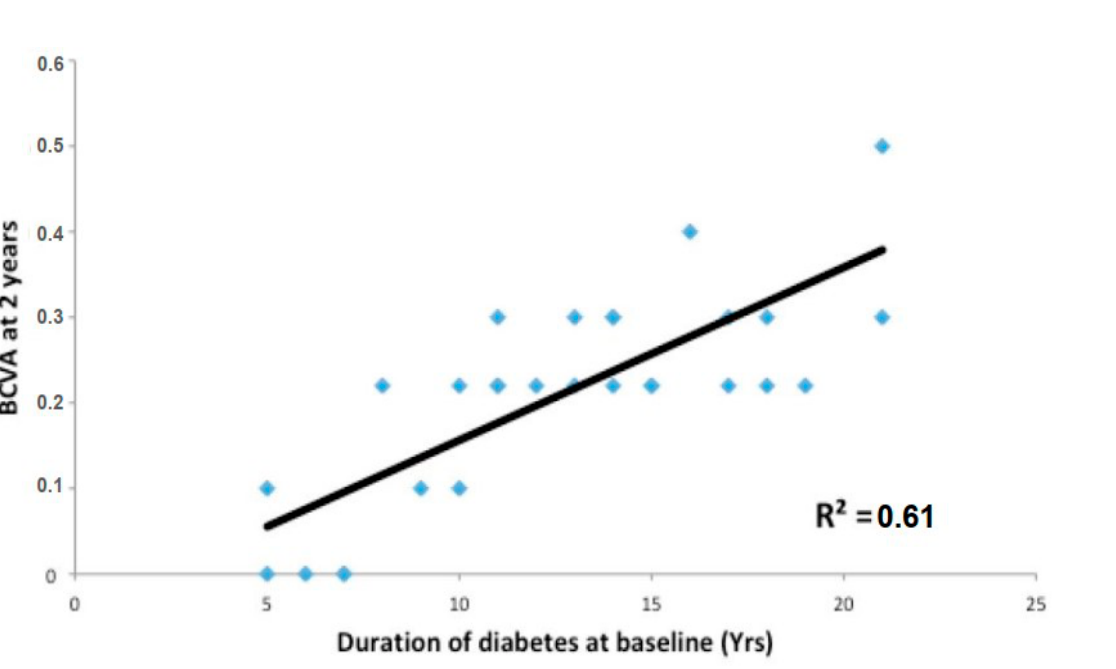
Figure 1. Pearson’s linear correlation between diabetes duration and final vision. BCVA. Best corrected visual acuity; Yrs, years.